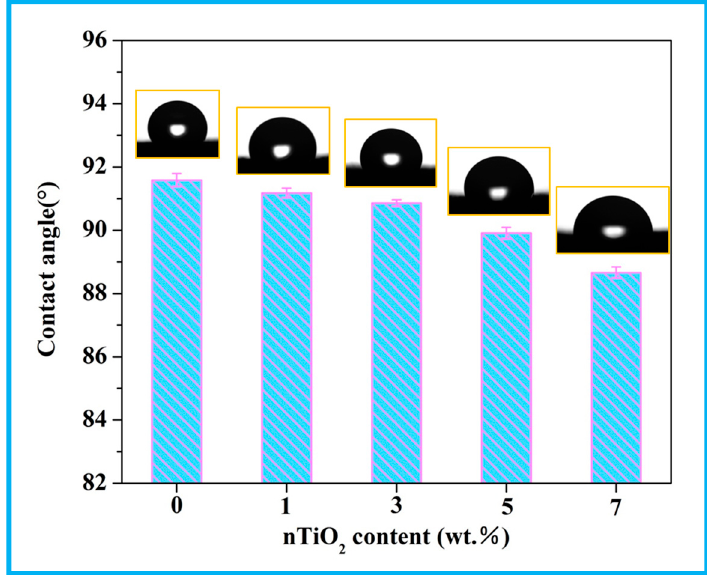
Figure 5. Water contact angle of the scaffolds with different nTiO 2 contents.